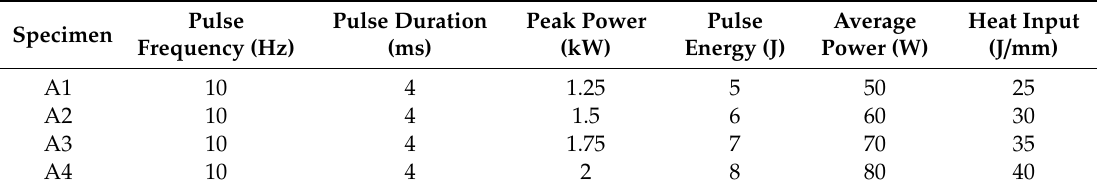
Table 2. Laser welding parameters.